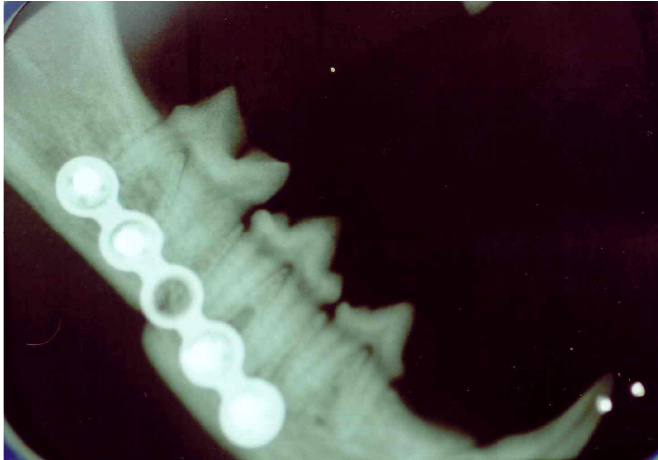
FIGURE 8 - Intraoral radiograph taken 12 weeks after surgery. Bone healing as manifested by obliteration of the osteotomy line. Cat 10 of Group 2.